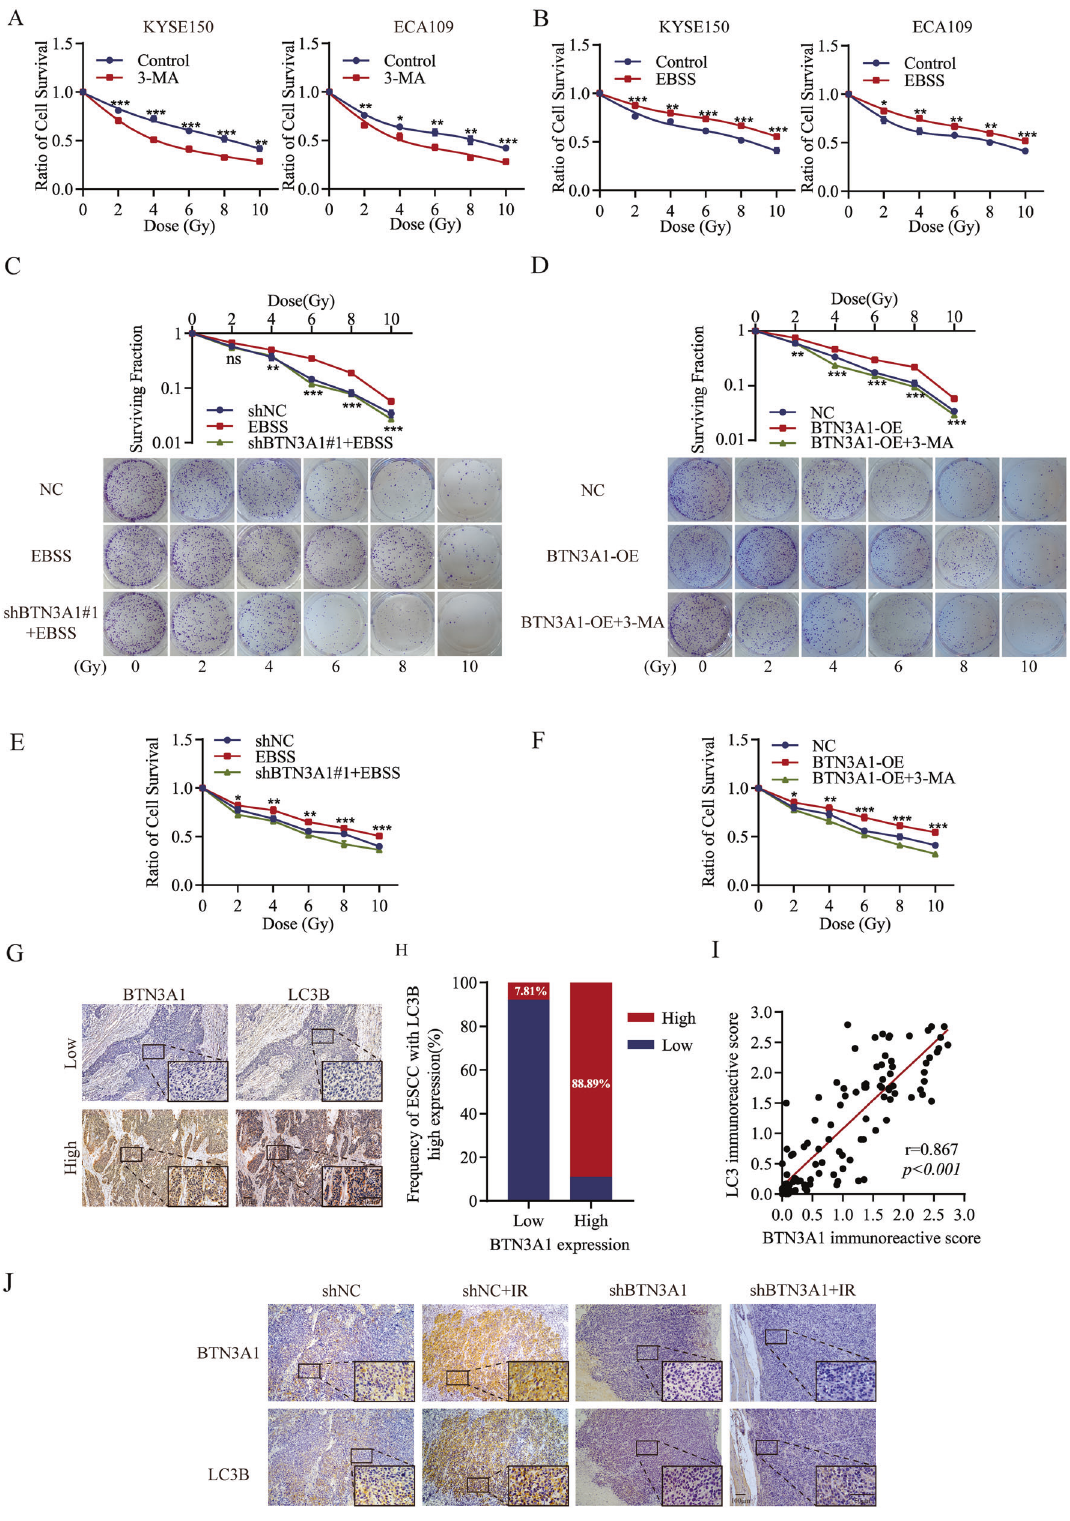
Fig. 5 BTN3A1 knockdown sensitizes ESCC cells to irradiation by inhibiting autophagy. A , B CCK-8 assays were performed to measure the relative viability of KYSE150 and ECA109 cells treated with 3-MA or EBSS after exposure to the different radiation doses (0 – 10 Gy). C , D Colony formation assays were performed to evaluate cell colony formation ability after radiation exposure (0, 2, 4, 6, 8, and 10 Gy) and culture cells for 10 days under EBSS ( C ) or 3-MA ( D ), respectively. E , F CCK-8 assays were performed to evaluate cell survival after radiation exposure and culture cells for 24 h under EBSS ( E ) or 3-MA ( F ), respectively. These data are representative of three independent experiments. Means±SD ( n = 3); t Student ’ s t tests; ** p < 0.01,*** p < 0.001. G – I Paraf fi n ESCC sections were used for IHC staining of the BTN3A1 and LC3B protein. Scale bar: 100 μ m. Correlation between the expression of the BTN3A1 and LC3B proteins. r, Pearson ’ s correlation coef fi cient. J Representative images of IHC staining for BTN3A1 and LC3B in xenograft tumors tissues. Scale bar, 100 µm, * p < 0.05, ** p < 0.01 and *** p < 0.001. Cell Death and Disease (2022)